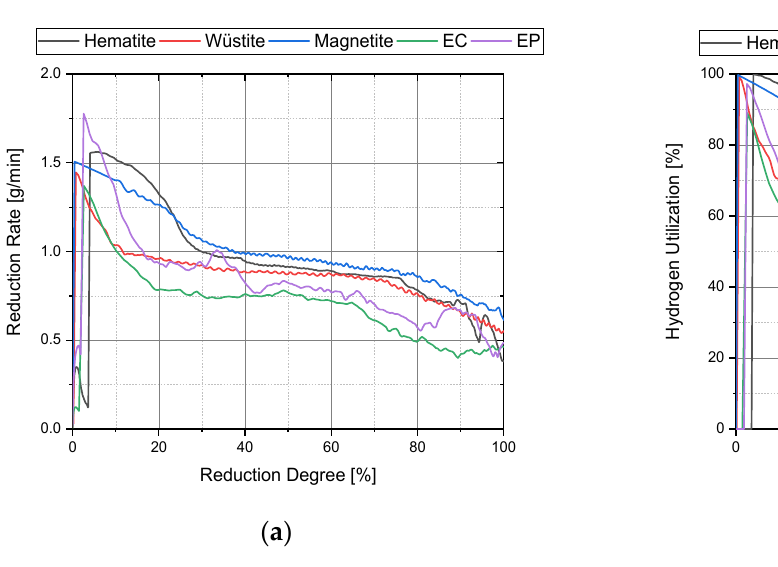
Figure 6. Reduction rate ( a ) and hydrogen utilization ( b ) over the reduction degree for various charged materials.